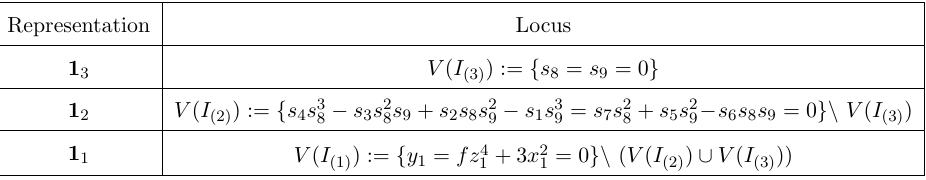
Table 4 . The loci for the charged matter representations under the U(1) symmetry. The charges are written as subscripts. The locus for the state 1 1 is given in terms of the sections x 1 , y 1 and z 1 discussed in appendix